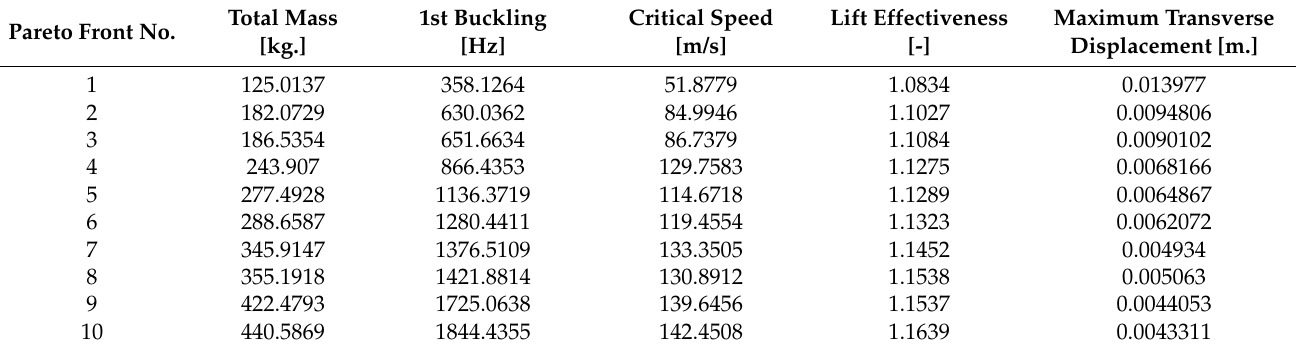
Table 3. Objective and constraint functions of some selected Pareto solution set from Figure 8b for Case. II. Pareto Front No.